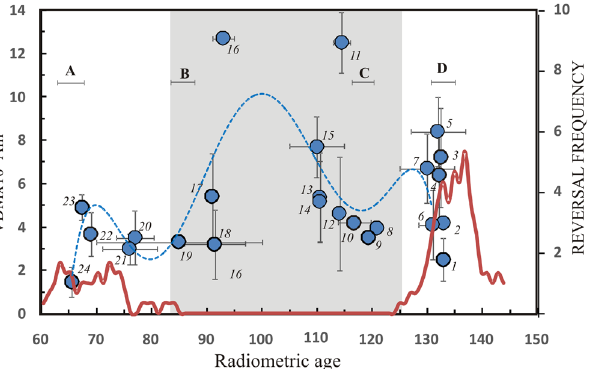
Figure 2. Distribution of VDM data during the Cretaceous period. The data set is as listed in table S-T2. Note a polynomial trend showing high dipole moment with low values on either end of the CNS. The numbers next to the data points are linked to the serial numbers in table S-T2. Also shown are the timing of mantle plumes of the Cretaceous responsible for the major large igneous provinces marked as A, B, C and D: A denotes the Reunion related Deccan flood basalt (and near synchronous ~62 Ma North Atlantic Tertiary Volcanic Province), B denotes the Marion plume related Madagascan igneous province (and near synchronous ~ 90 Ma Ontong Java plateau), C denotes the Kerguelen plume related Rajmahal volcanism and D denotes the Tristan da Cunha plume related Parana basalts. The ages of these LIPs are shown with error bars. It can be seen the low dipole moments correspond to the mantle plumes/LIPs in age. Area coverage of LIPs in each age bracket (A: > 3; B: < 3.5; C: ~2 and D: ~1.5 in million km 2 ) 49,50 may indicate a measure of their magnitudes. Polarity reversal frequency with 3 Ma running average from the 2012 GPTS 51 is shown in red line. The grey shade demarcates the